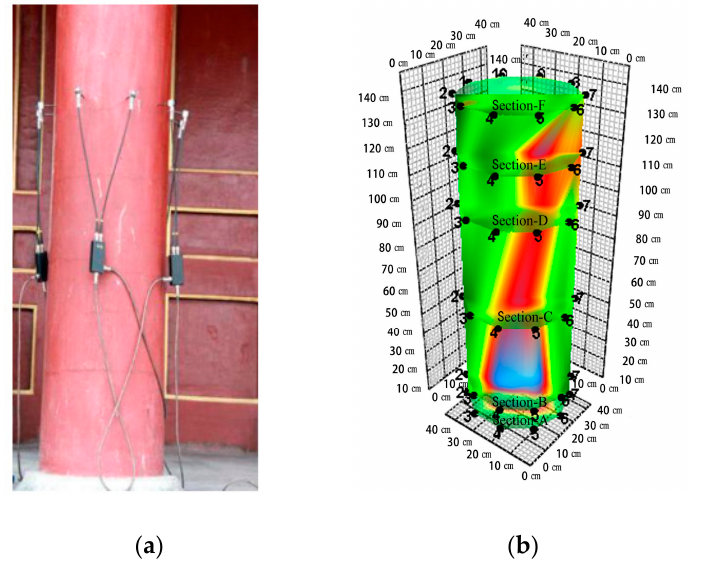
Figure 4. Nondestructive testing of stress wave: ( a ) Stress wave data acquisition; ( b ) Internal damage imaging model. Note: Green represents healthy material, red represents loose material with damage, and blue represents interior cavities.